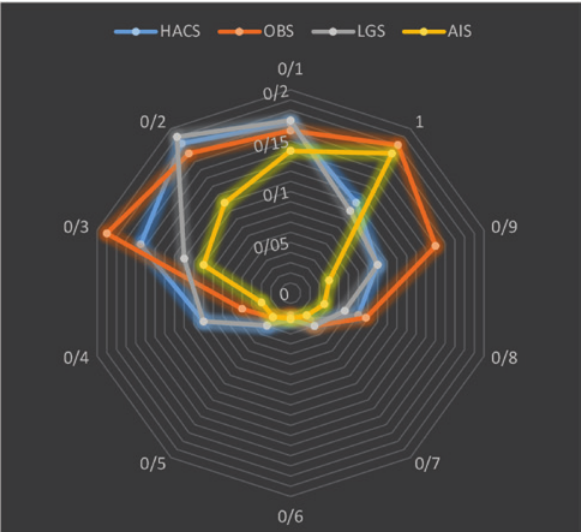
Figure 2: Mean Best DBI Values with Different Values of α for All Four Cases.